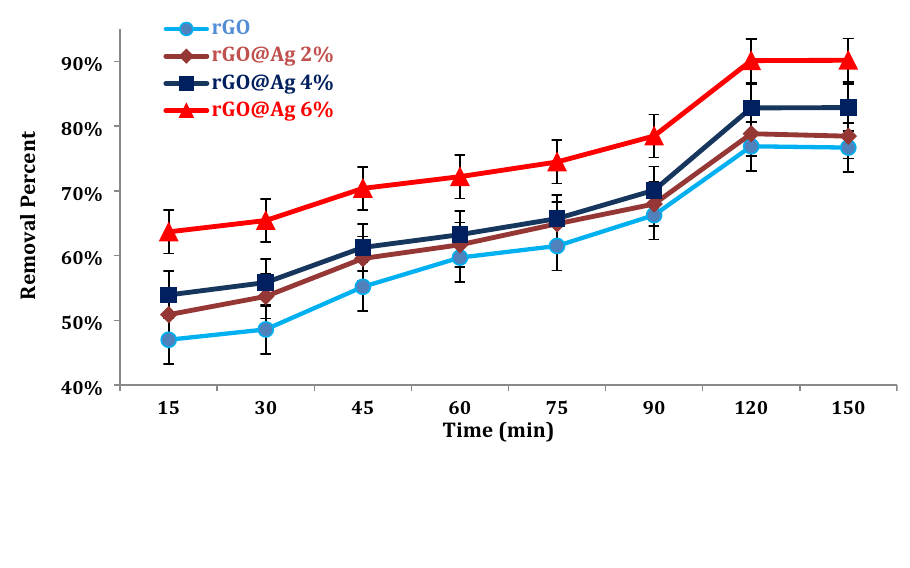
Table 1 Comparison between degradation of different organic dyes using different photocatalysts